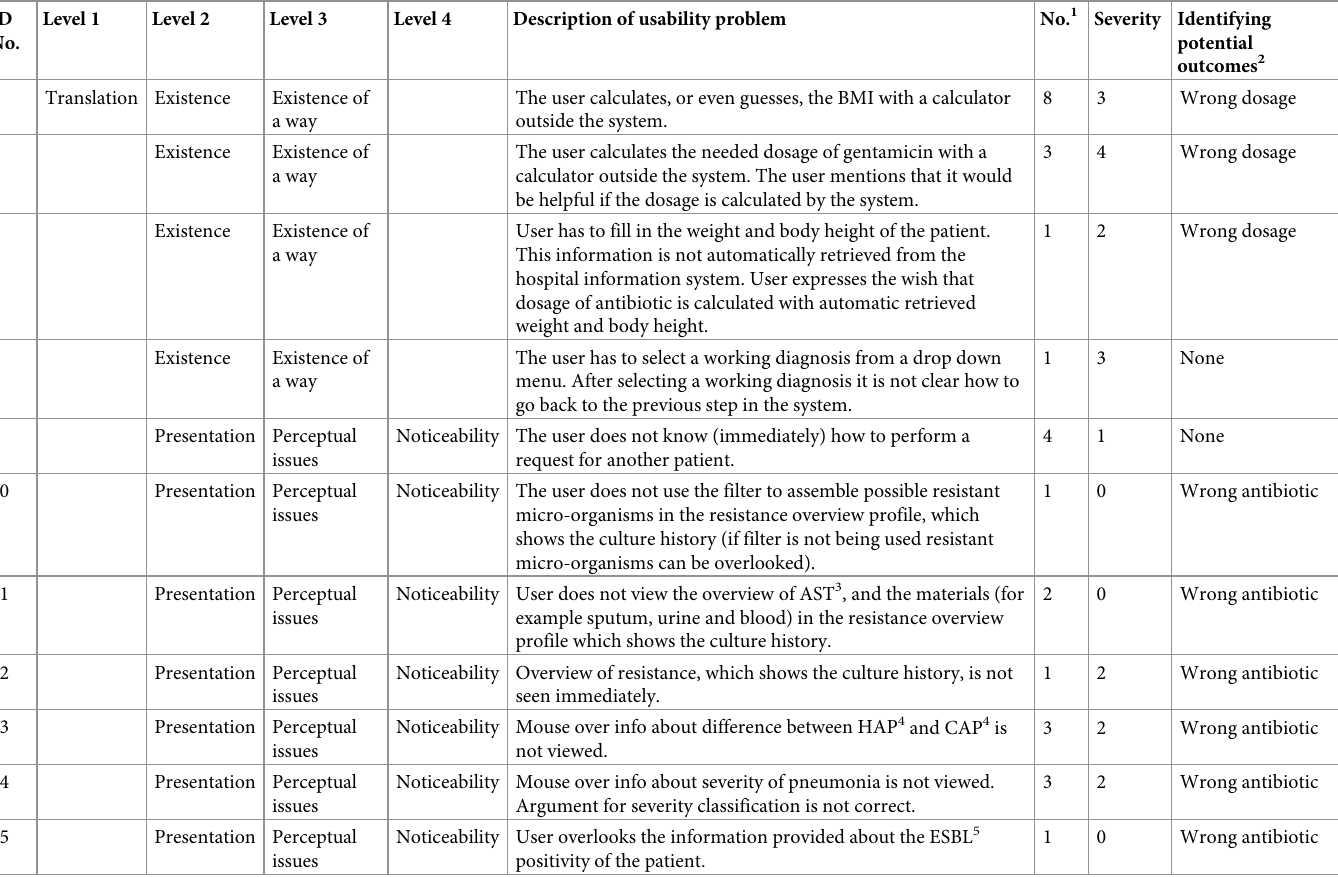
Table 2. Usability problems in the UAF translation phase with their severity and potential effect on task outcome. ID Level No.